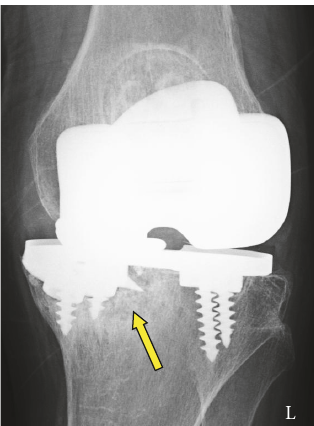
Figure 3: Follow-up plain radiograph obtained 16 years after the surgery shows disappearance of the medial joint space, subsidence of the broken baseplate, and osteolysis under the medial compartment (arrow).